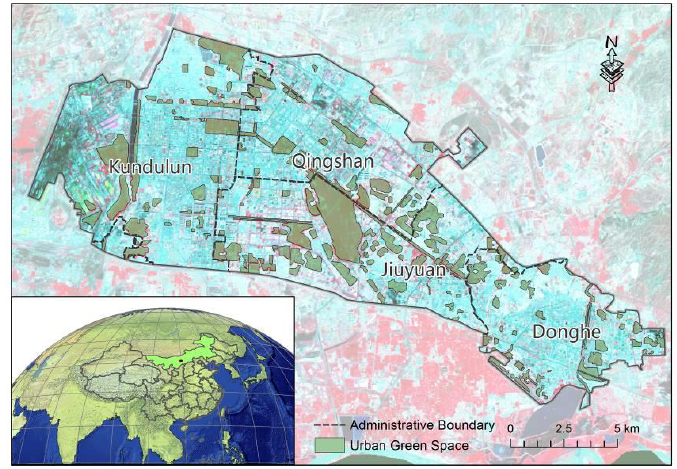
Figure 1. Location map of the study area.